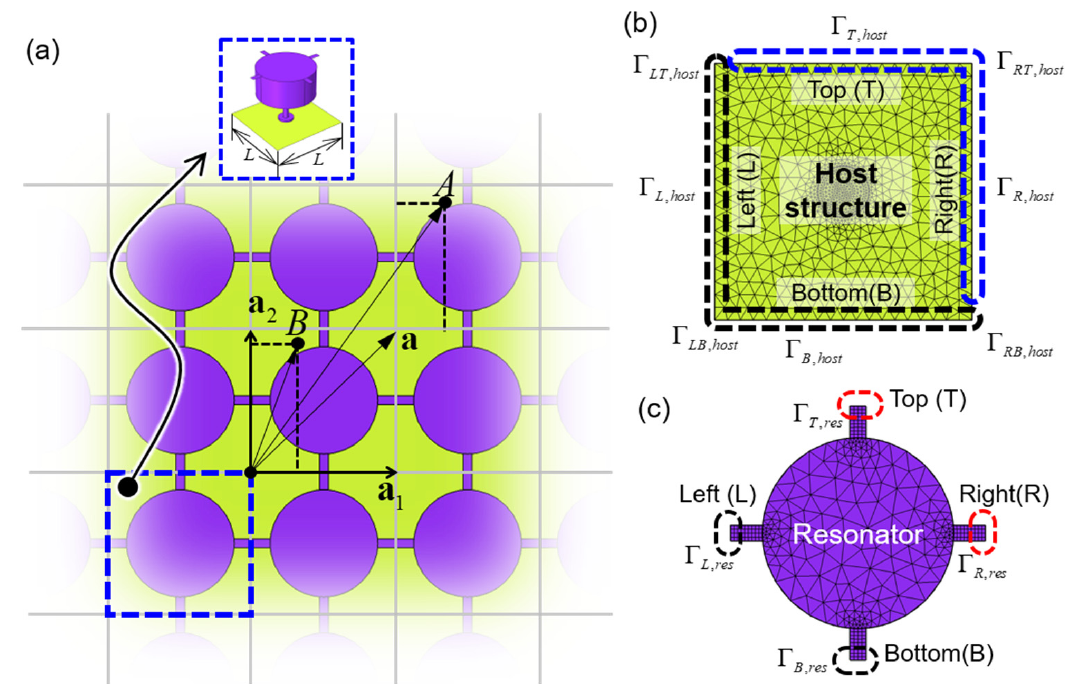
Figure 2. Schematic diagram describing ( a ) the Floquet–Bloch boundary condition of the unit-cell structure and each boundary of ( b ) the host structure and ( c ) resonator .